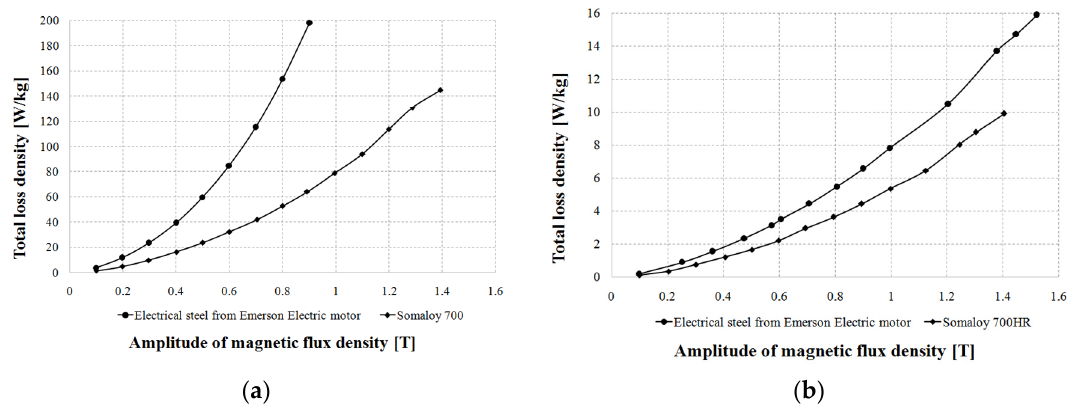
Figure 6. ( a ) Graphs of iron loss density vs. magnetic flux density for electrical steel from the Emerson Electric motor and for Somaloy 700 materials measured at 600 Hz; ( b ) graphs of iron loss density vs. magnetic flux density for electrical steel from the Emerson Electric motor and for Somaloy 700HR materials measured at 50 Hz.